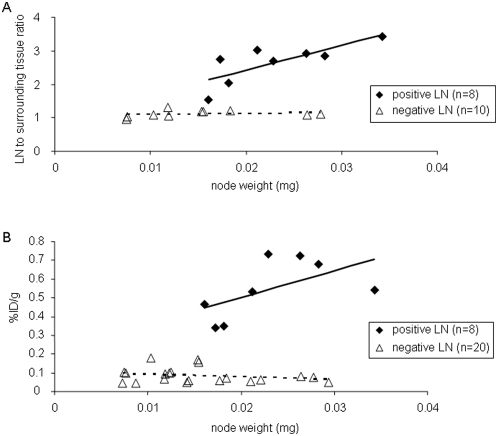
Radioactivity measurements and lymph node weight.(A) Lymph node-to-surrounding tissue radioactivity ratios obtained from the [18F]FEAU PET images in NV1023-treated animals versus lymph node weight (8 positive nodes (♦) R2 = 0.603; y =  74.0x+0.939 and 10 negative nodes (▵) R2 = 0.035; y = 2.62x+1.080). (B) Ex vivo radioactivity measurements from excised lymph nodes. Lymph node radioactivity (%ID/g) in NV1023-treated animals versus lymph node weight (8 positive nodes (♦) R2 = 0.328; y = 14.4x+0.214 and 20 negative nodes (▵) R2 = 0.054; y = −1.40x+0.108).